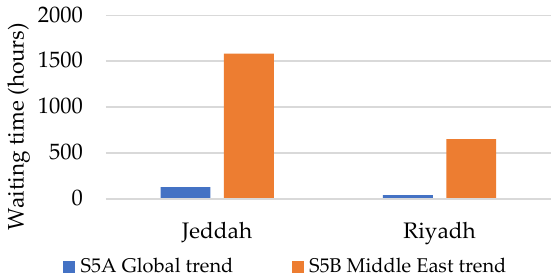
Figure 12. Comparing inventory waiting time for S5A (Global) and S5B (Middle East). As can be seen, the truck waiting time was lower for S5A compared to S5B at the Riyadh warehouse but higher for S5A compared to S5B in Jeddah warehouse. However, the difference in Jeddah warehouse was less than 9%. Figure 13 shows the difference in truck waiting time for both sub ‐ scenarios.